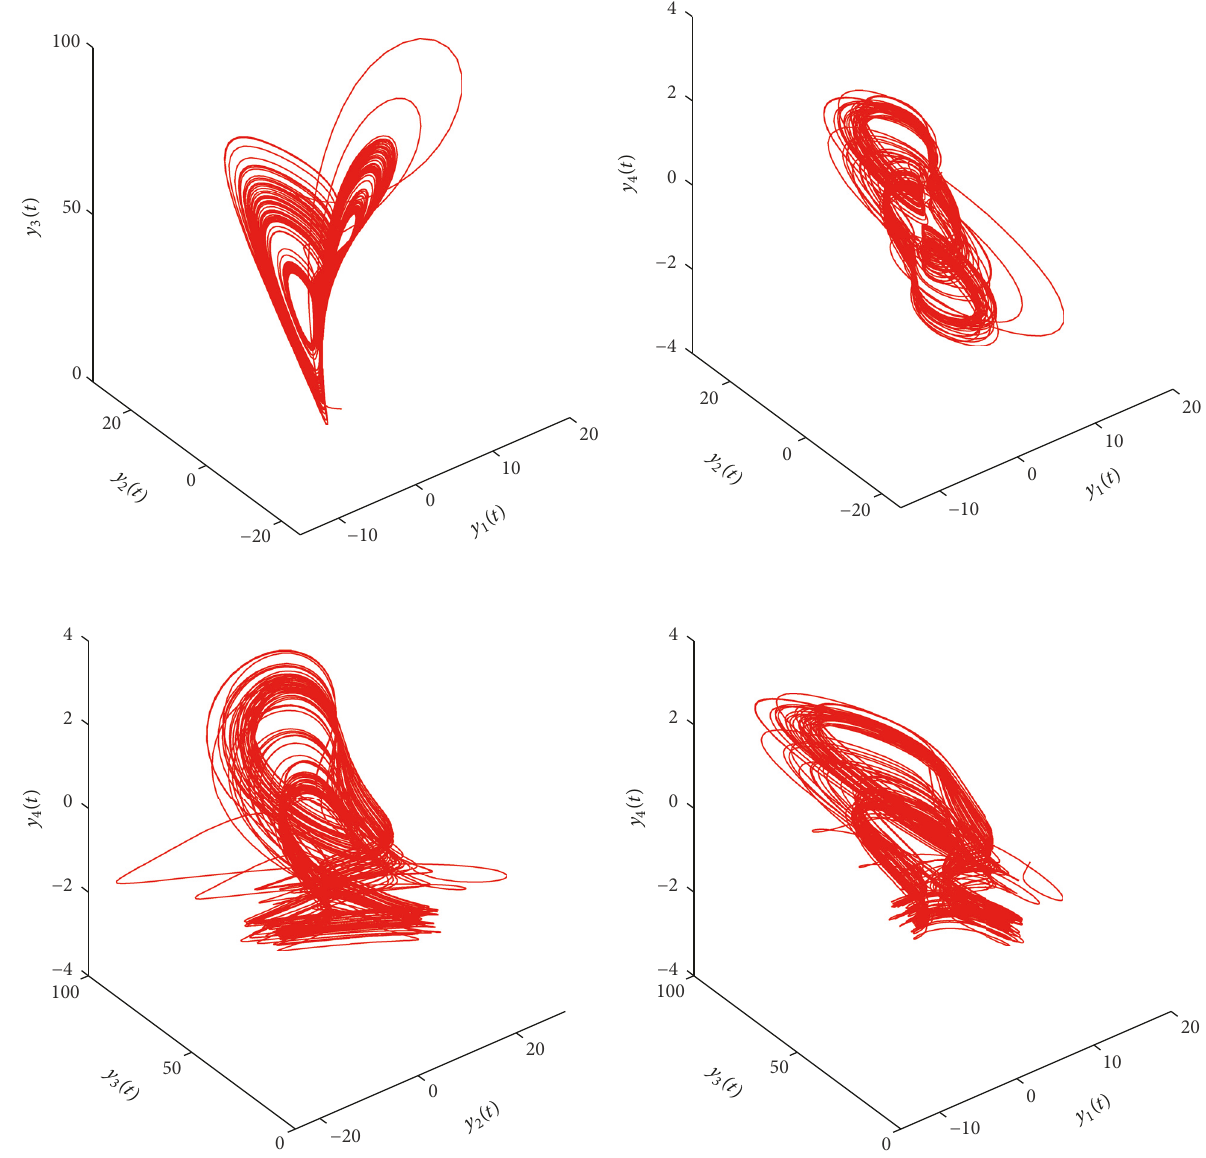
Figure 2: 3D phase portraits of the fractional hyperchaotic Liu